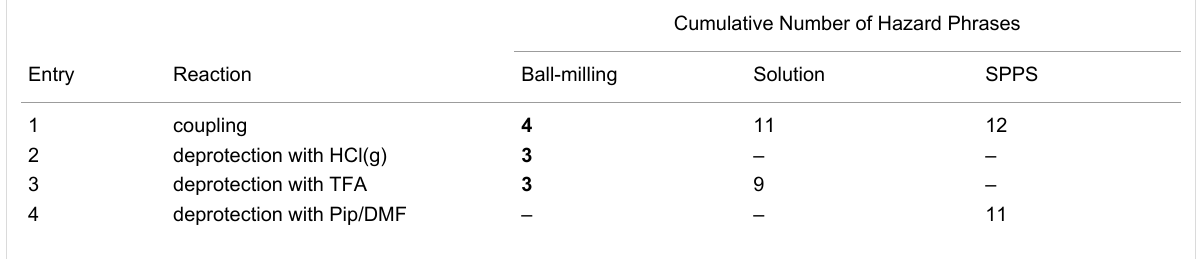
Table 3: Comparison of the cumulative Number of Hazard Phrases (for each entry, the best result is indicated in bold).